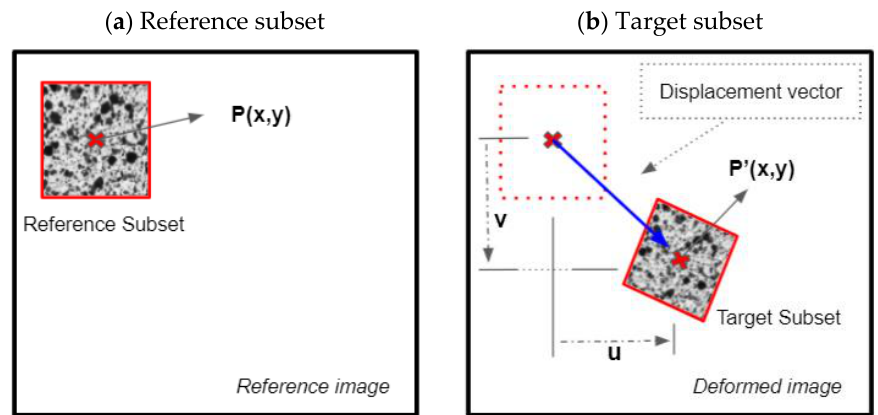
Figure 2. Schematic representation of DIC based on the correlation between the reference subset ( a ) and the target subset ( b ). The variables 𝑢 and 𝑣 represent the displacement experienced by the subset in the deformed image with respect to the reference image.